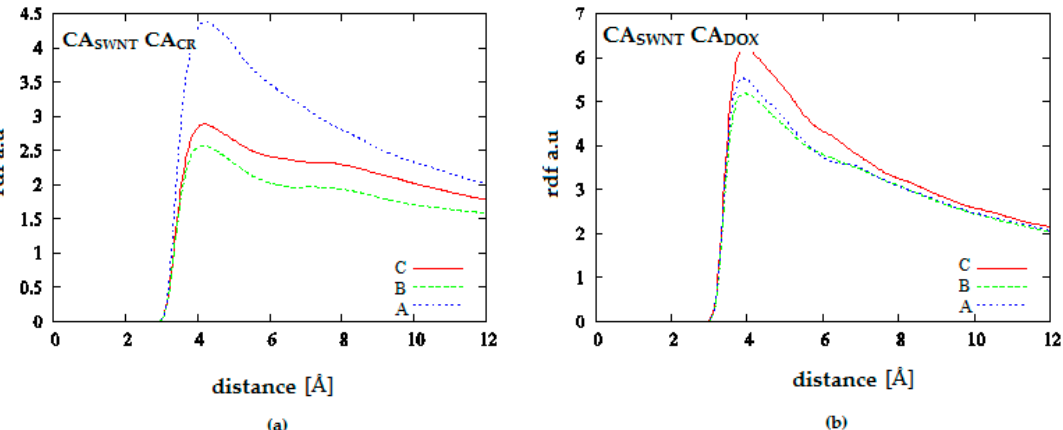
Figure 15. Radial distribution functions for the system SWNT (30.0) complexed with 40 molecules of CR and 10 molecules of DOX; ( a ) SWNT-CR interaction; ( b ) SWNT-DOX interaction; (A—neutral pH, B—medium pH, C—acidic pH).